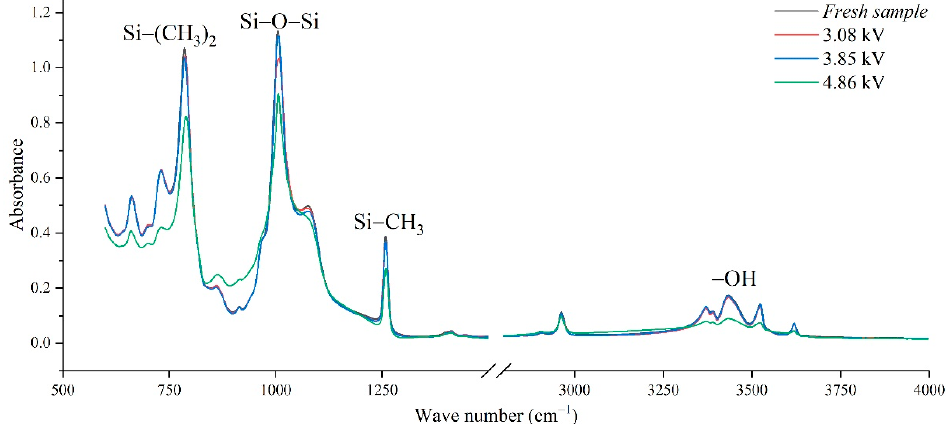
Figure 11. FTIR test results of different applied voltage (pH = 2.4, t = 8 h).